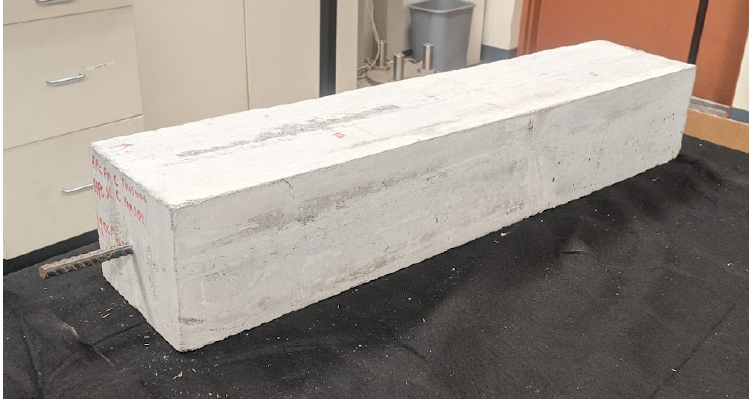
Figure 1. Example of a concrete beam sample; note central rebar.